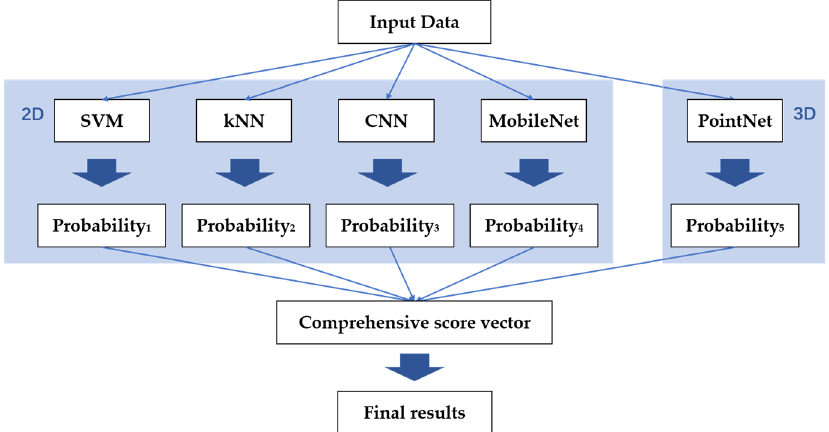
Figure 7. Flowchart of the improved voting method.